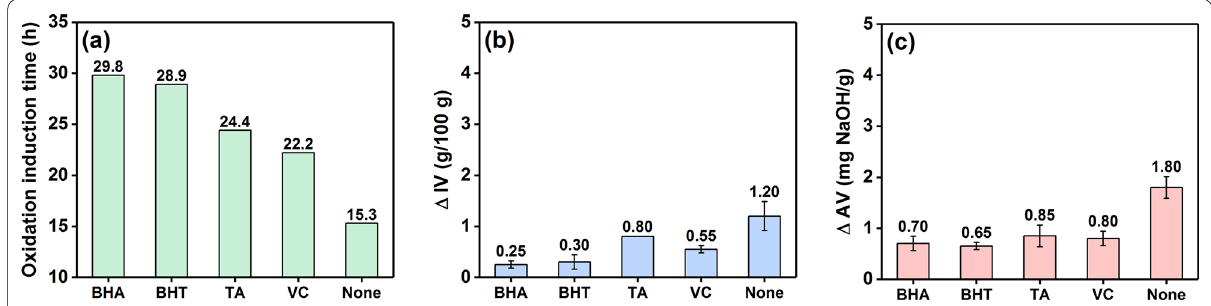
Fig. 7 Effect of antioxidant on oxidation induction time ( a ), ∆ IV ( b ), and ∆ AV ( c ) of sulfated rape